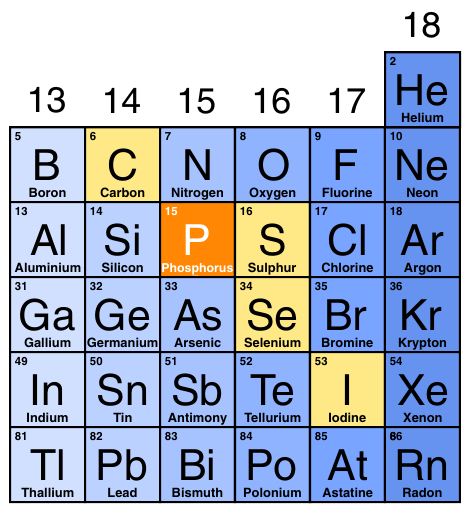
Fig. 5 The missing tile of P for group 15. Non-metal region of the Periodic Table showing the elements (yellow and orange) able to form crystalline X 2 H 2 vdW compounds (X = CH 4 19 , PH 3 , H 2 S 26 , H 2 Se 27 , HI 57 ) having the I 4 cm ( I 4/ mcm ) structure, with P (X = PH 3 ), highlighted in orange, representing the so far missing tile for group 15 elements reported in this study (see text).